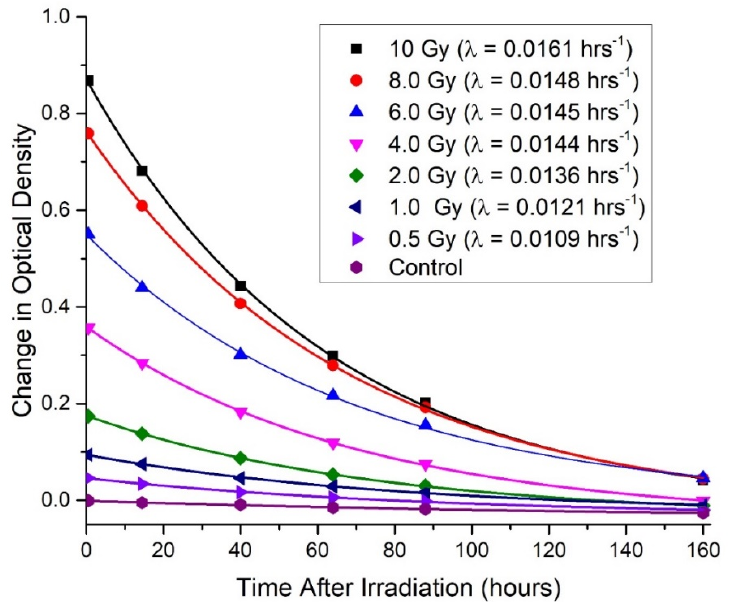
Figure 4. After initial irradiation, the clearing curves for the Formulation 1 cuvettes irradiated up to a maximum dose of 10 Gy were tracked for several days for all seven irradiated cuvettes. Fits to the curves were performed using a three-parameter fit function of the form y = y 0 + Ae −λ t .